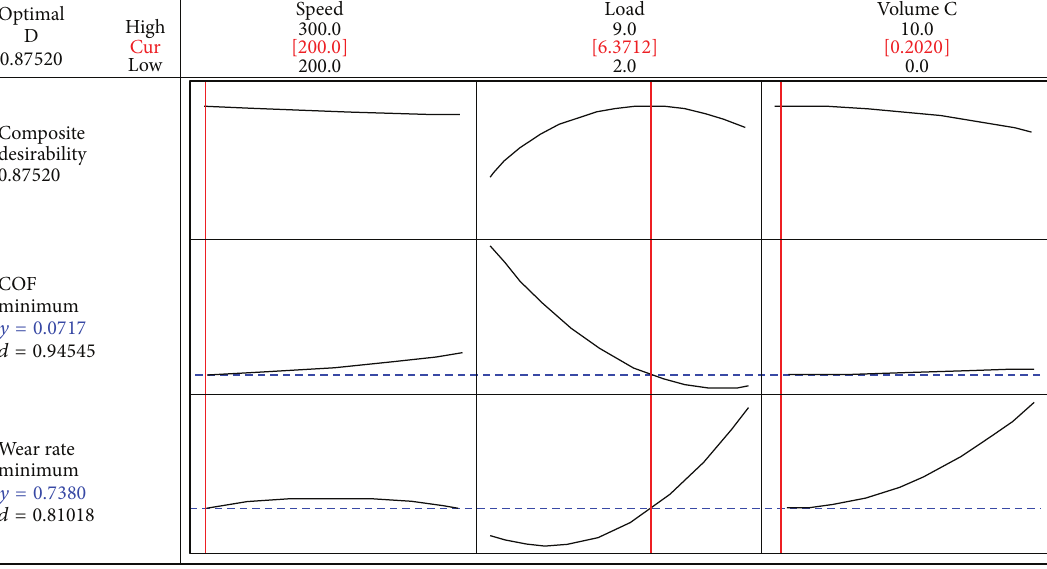
Figure 9: Optimal conditions for control variables on the wear and friction responses of blended waste oil with SAE.